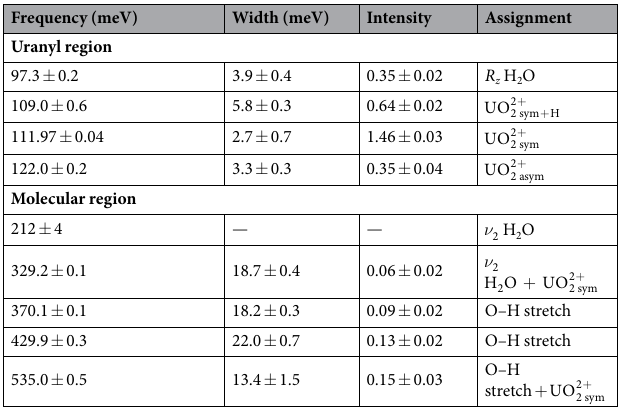
Table 1. Phonon Density of States Band Assignment and Fitting Parameters. All fits are Gaussian, and widths are